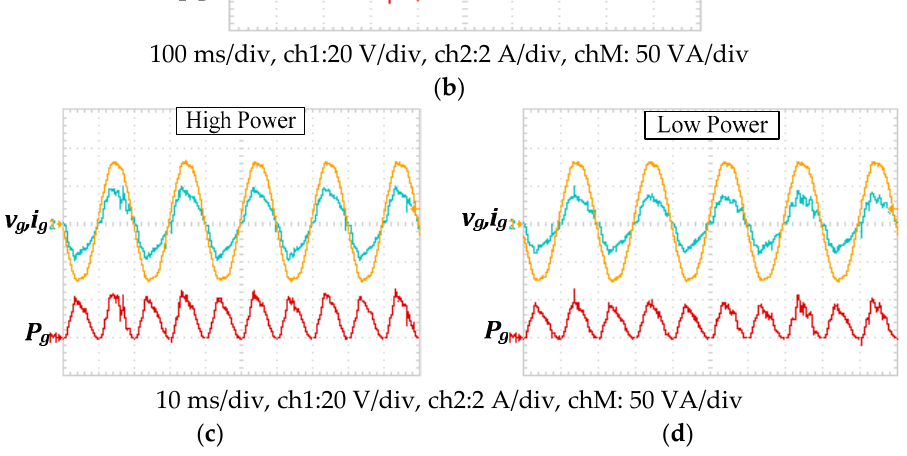
Figure 6. System performance applying CPRC, grid voltage THD = 3.9% ( a ) PV voltage, current and power, ( b ) Grid voltage, current and power, ( c , d ) zoom of Grid voltage, current and power at high and low power levels respectively.